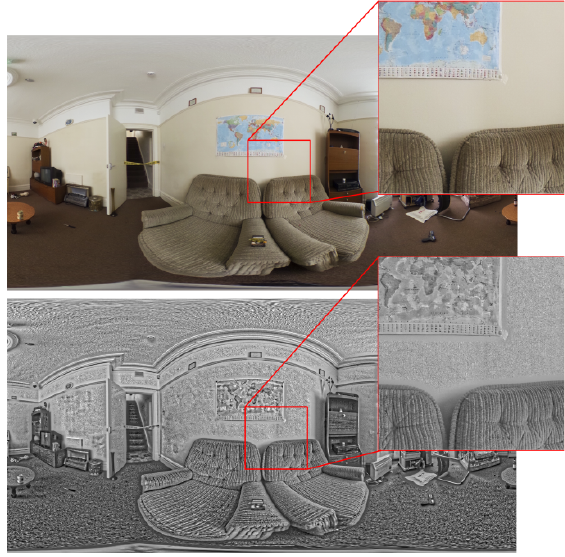
Figure 4. Example of the image pre-processing pipeline: original panorama (above) and pre-processed one (bottom).